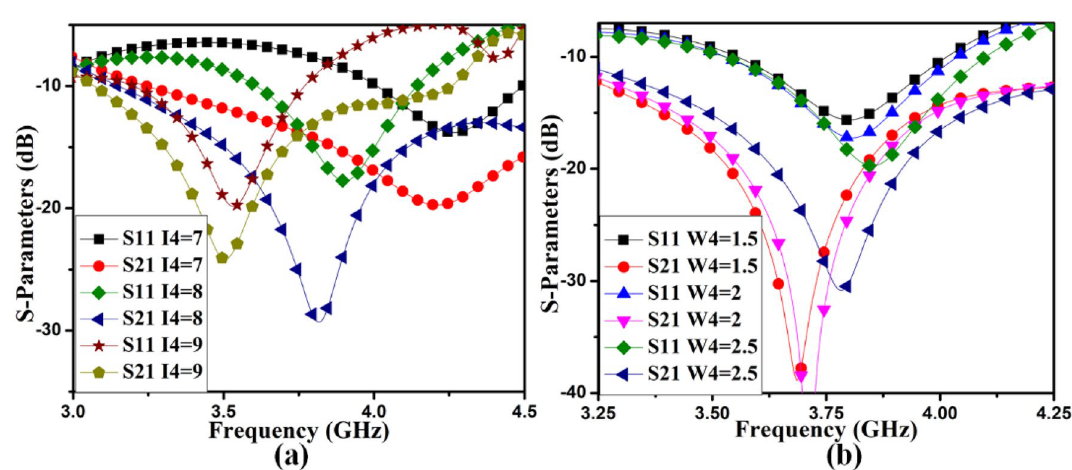
Figure 7. AntII S-parameter variation due to ( a ) I4, ( b ) W4.